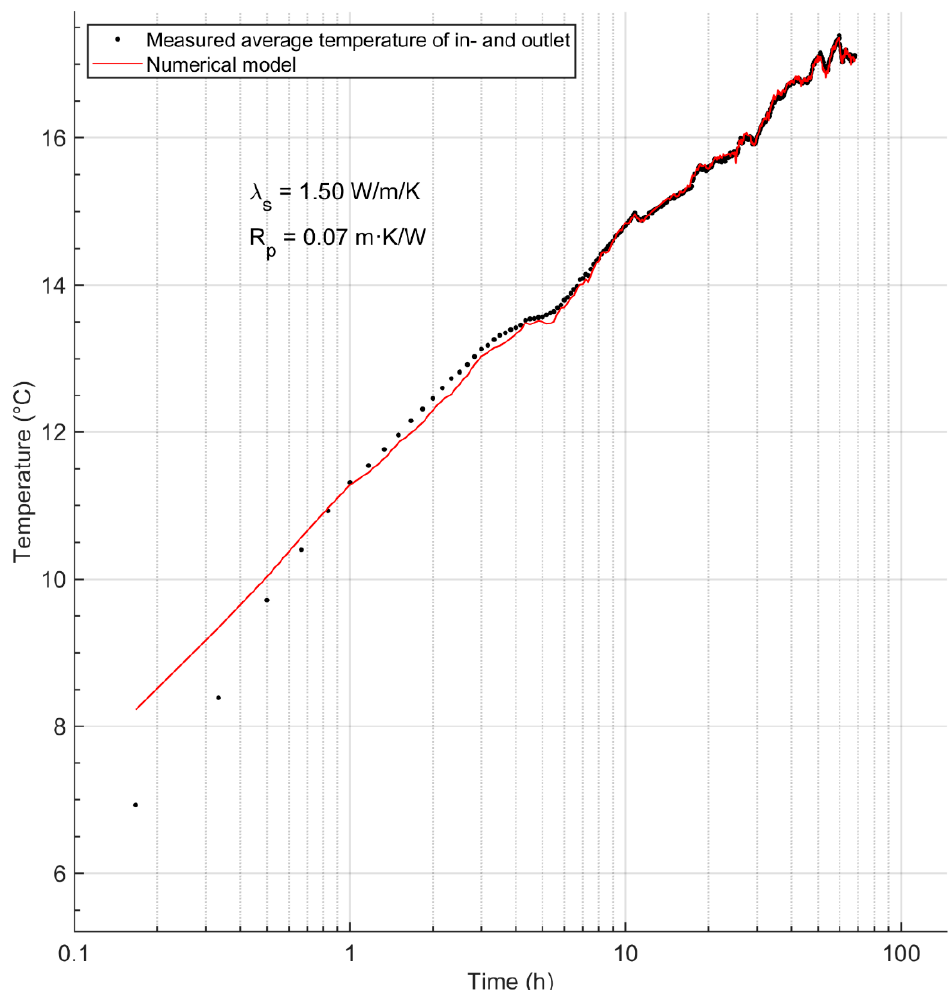
Figure 7. Numerical model interpretation of the TRT of the roadbed geothermal piping from the Thermoroad (duration: 48 h).